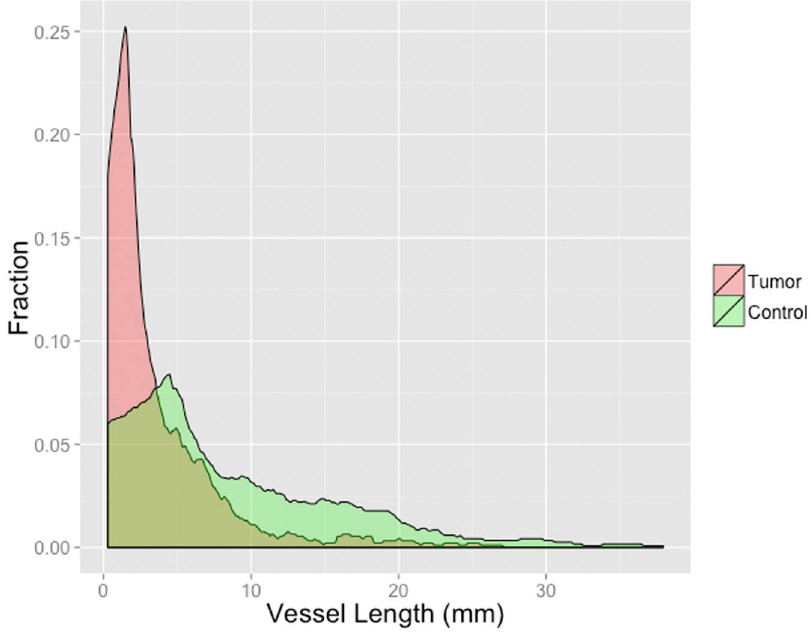
Figure 4. Histogram of mean vessel branch length; the area under the curve is normalized to